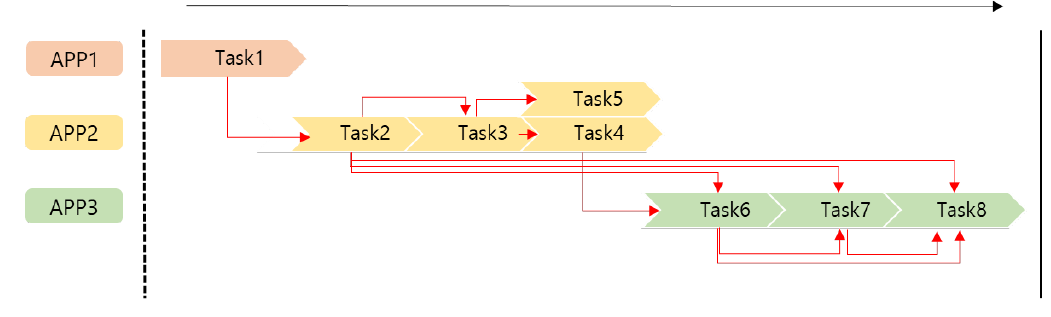
Figure 4. Workflow and Task Connectivity.